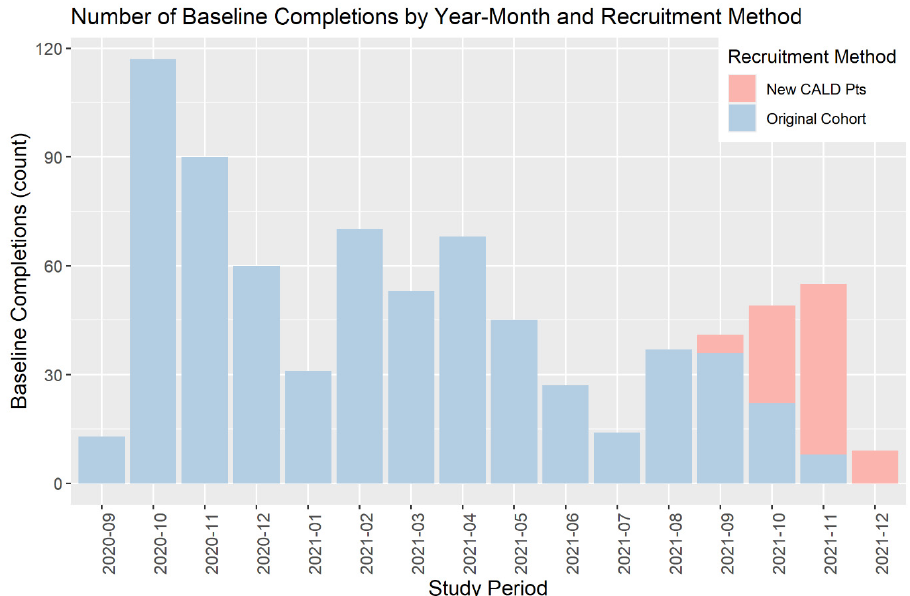
Figure 1. Describes the number of participants who completed baselines in each month. Colours distinguish participants who were recruited as part of the original cohort and those who were re- cruited after protocol revisions to target recruitment of CALD participants. Table 3. COVID experiences by language group.